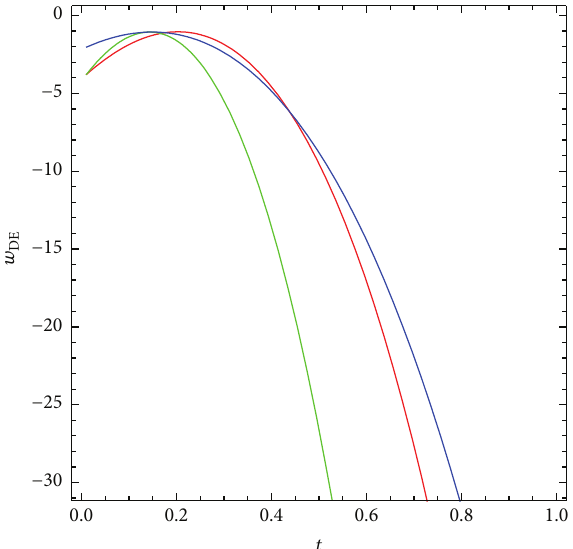
Figure 1: EoS parameter based on (22). Red, green, and blue lines correspond to {𝛼,𝛽} combination of {0.9735, 0.3701} with 𝜂 = 3.5 × 10 −4 , 3.0 × 10 −4 , and 2.5 × 10 −4 , respectively.